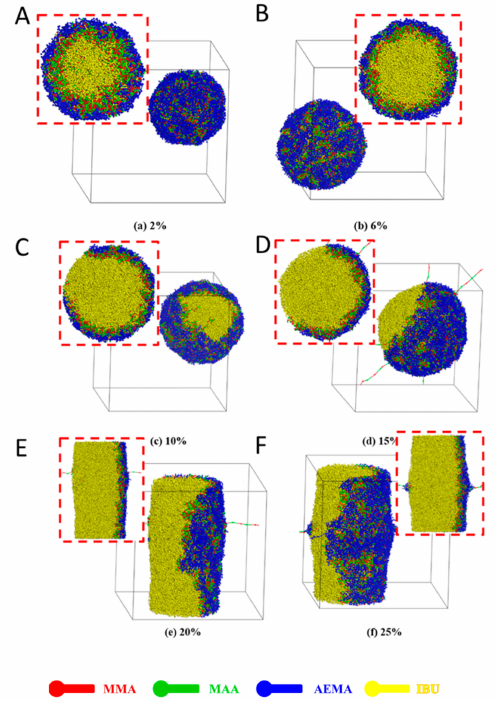
Figure 4. Full-section and cross-section views of IBU-loaded system self-assembled from amphiphilic block copolymer poly(MMA 30 - co -MAA 33 )- b -PAEMA 38 together with di ff erent mole fraction of IBU in aqueous solution ( A ) 2%, ( B ) 6%, ( C ) 10%, ( D ) 15%, ( E ) 20%, ( F )